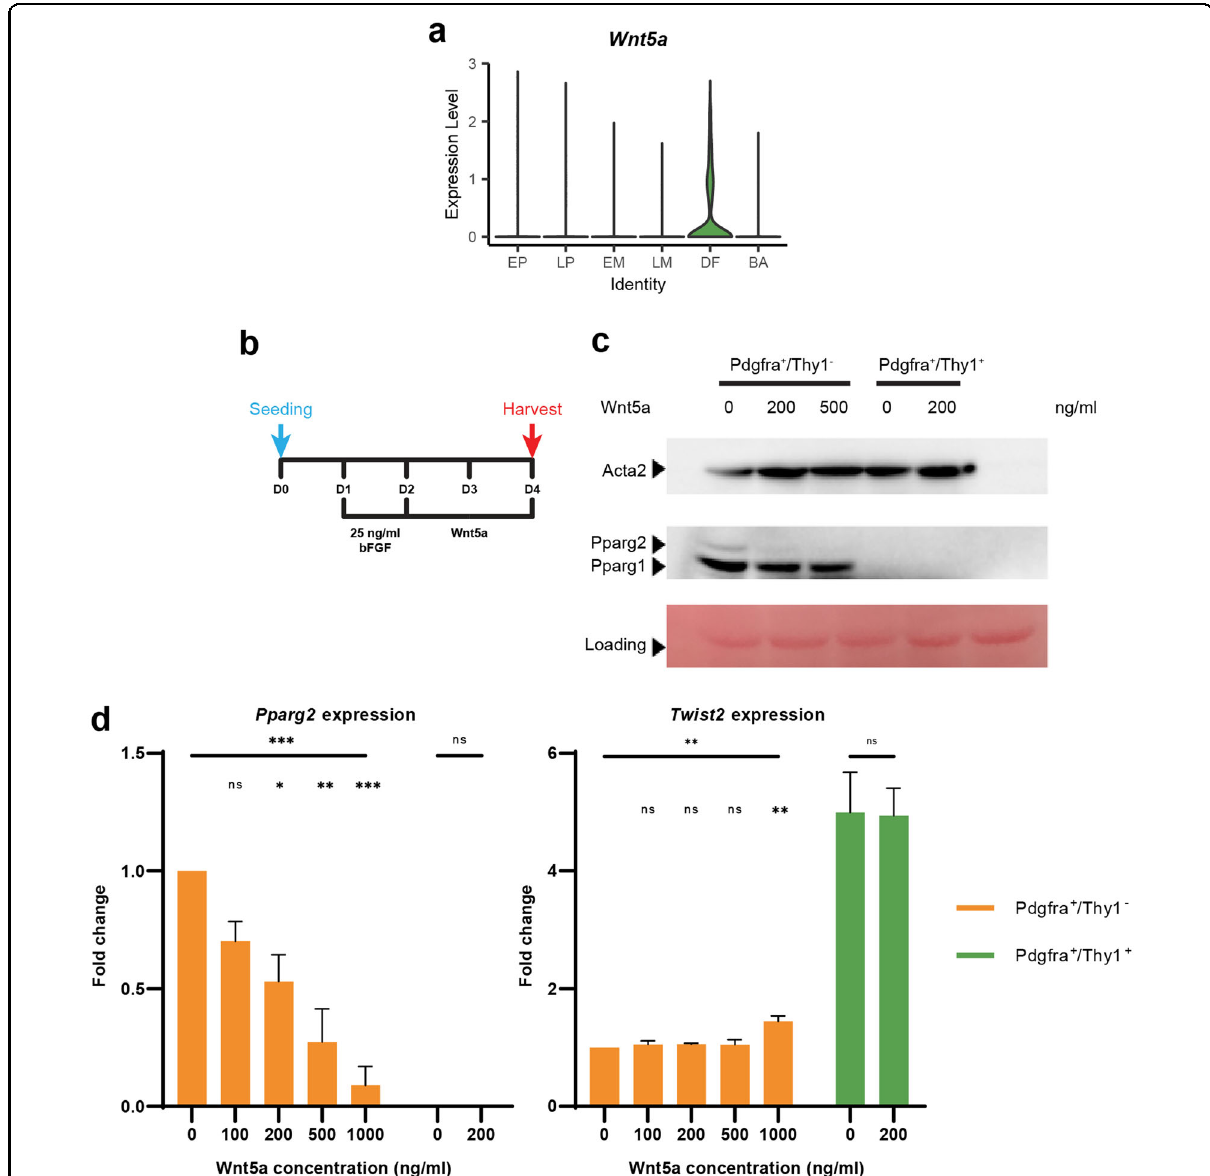
Fig. 7 Wnt5a inhibits adipogenic gene expression in embryonic multipotent progenitors. a Violin plot of Wnt5a expression in Smart-seq2 and 10× datasets. b Scheme of Wnt5a treatment on embryonic progenitor cells. E14.5 embryos were harvested, and both Pdgfra + /Thy1 − and Pdgfra + / Thy1 + populations were sorted. Cells were treated with 2.5 ng/mL bFGF to reach con fl uency. Wnt5a was then applied and 48 h after treatment, cells were harvested for analysis. c Embryonic cells were harvested and subjected to Western blot assay. Ponceau S staining was used as loading controls. d RT-qPCR analysis of Wnt5a-treated embryonic progenitor cells in b . One-way ANOVA was performed on Pdgfra + /Thy1 − cultured cells, followed by Dunnett ’ s multiple comparisons test. Student ’ s t -test was performed in Pdgfra + /Thy1 + cultured cells. Values are means ± SEM, n = 3; ns, not signi fi cant; ** P < 0.01, *** P <